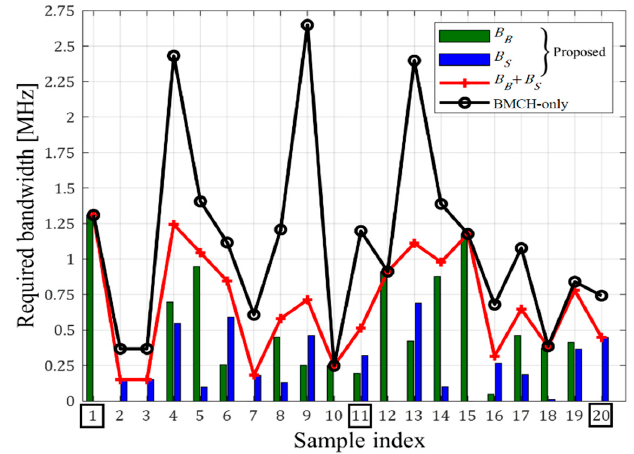
Figure 3. Average bandwidth versus |Ω (cid:3003) | ( |Ω| = 6) .